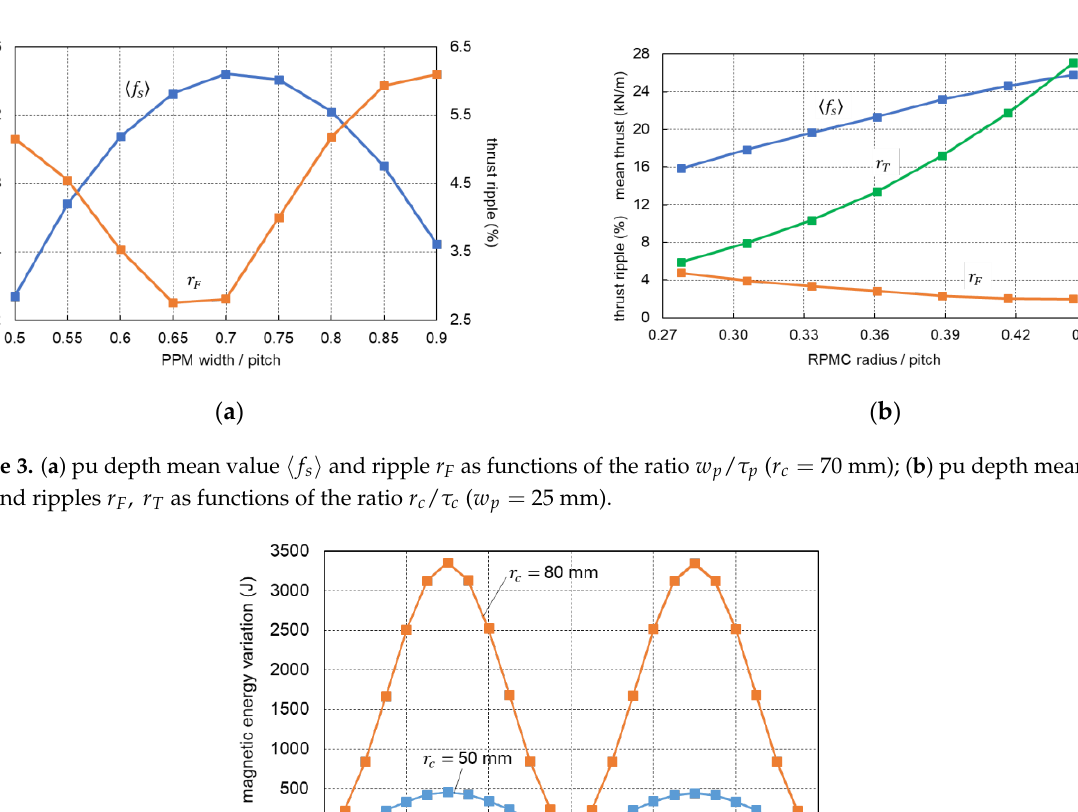
Figure 3. ( a ) pu depth mean value 〈𝑓 𝑠 〉 and ripple 𝑟 𝐹 as functions of the ratio 𝑤 𝑝 /𝜏 𝑝 ( 𝑟 𝑐 = 70 mm); ( b ) pu depth mean value 〈𝑓 𝑠 〉 and ripples 𝑟 𝐹 ,𝑟 𝑇 as functions of the ratio 𝑟 𝑐 /𝜏 𝑐 ( 𝑤 𝑝 = 25 mm).